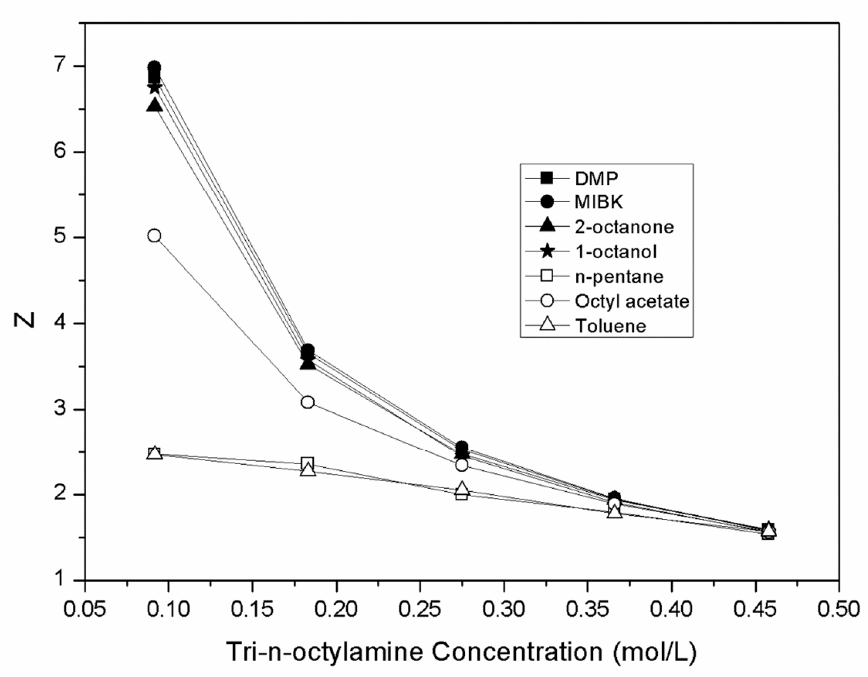
Figure 3. Plot of the loading factors (Z) versus the molar concentrations of TOA (C TOA,org ) in different